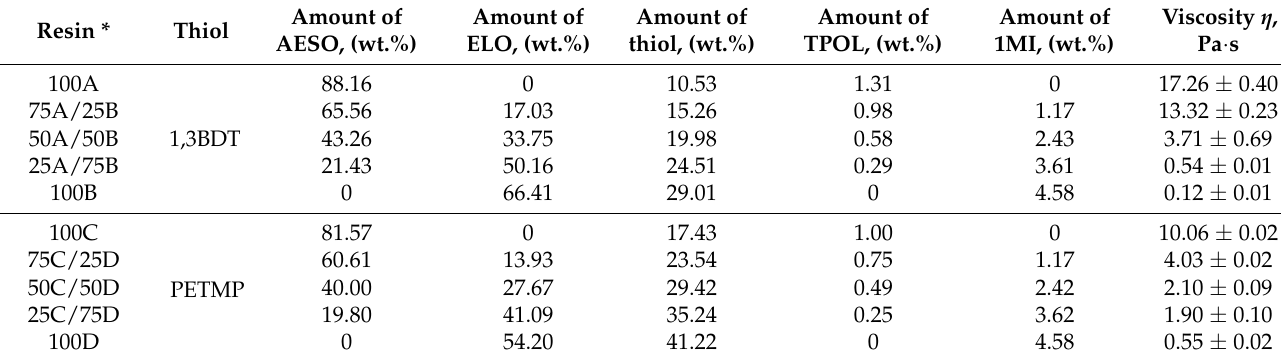
Table 1. Composition and viscosity of prepared